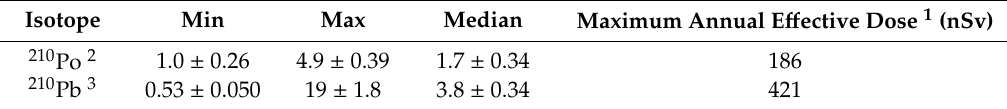
Table 4. Activity concentrations for polonium and lead measured in bottled water (mBq / L).